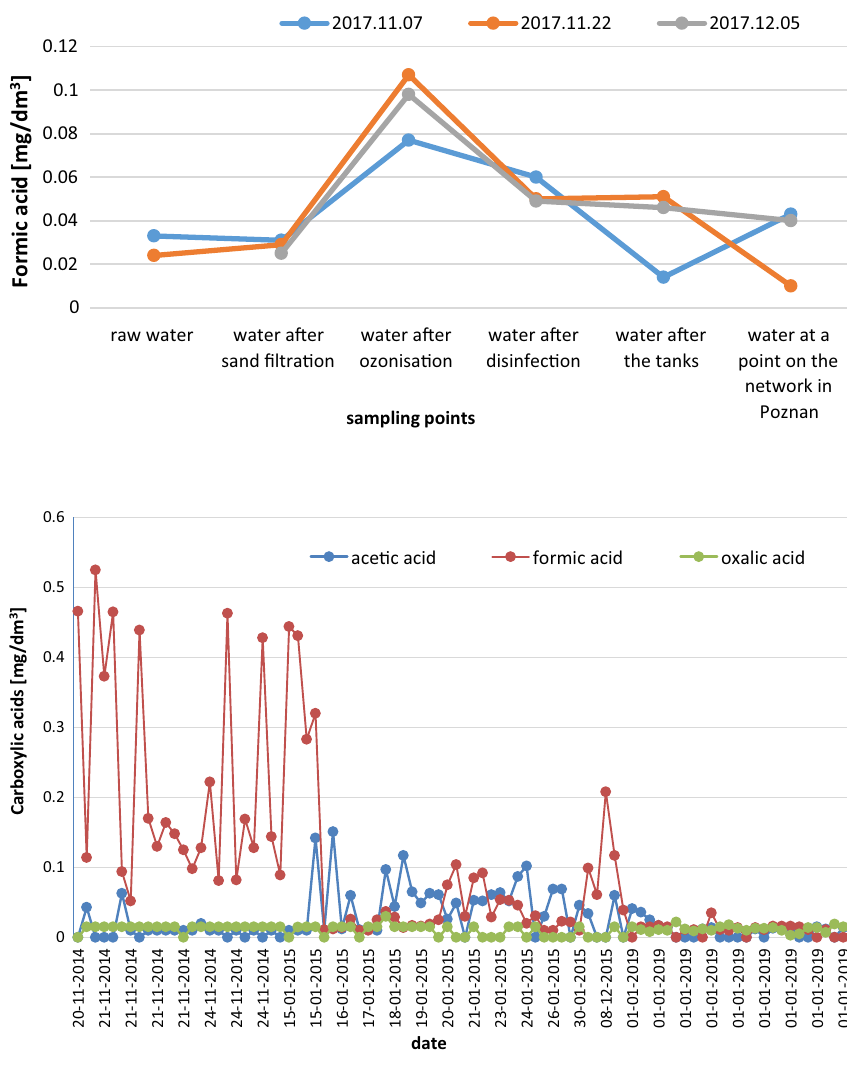
Fig. 9 Formic acid concentra- tion after individual processes and at a point on the Western Main network in 2017